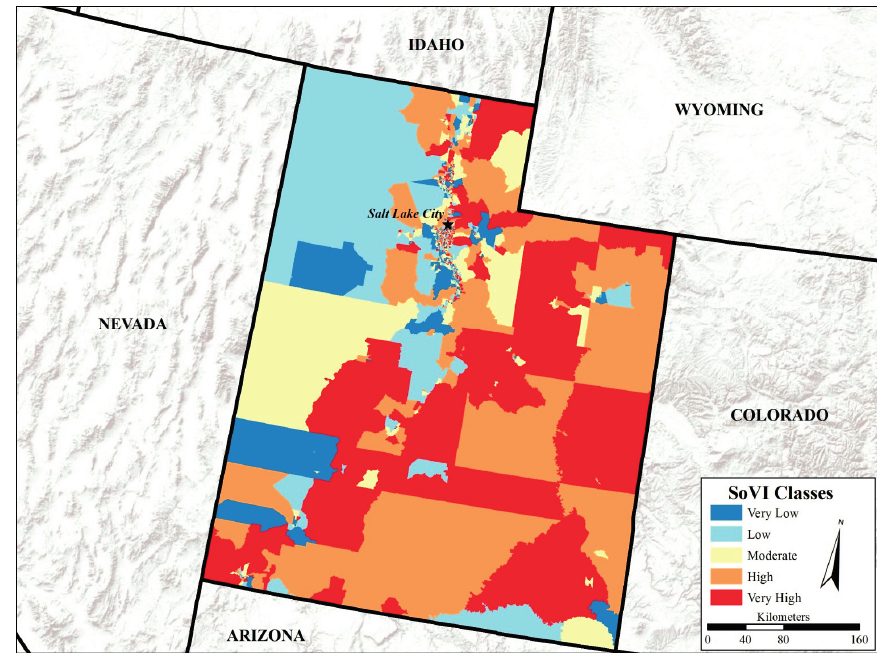
Figure 3. The SoVI constructed for the state of Utah using the traditional approach.